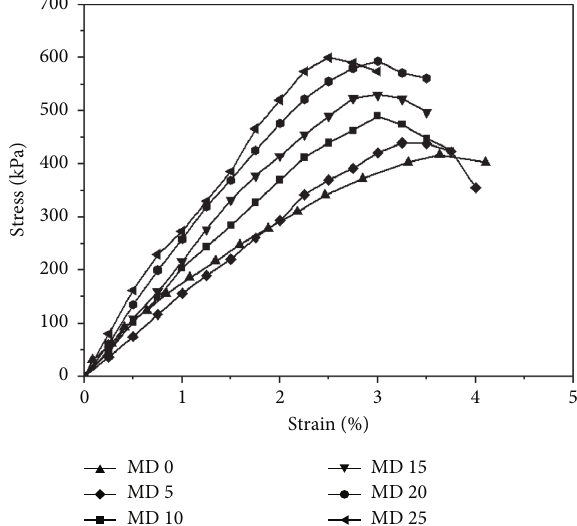
Figure 10: Stress-strain curves at different percentages of MD.